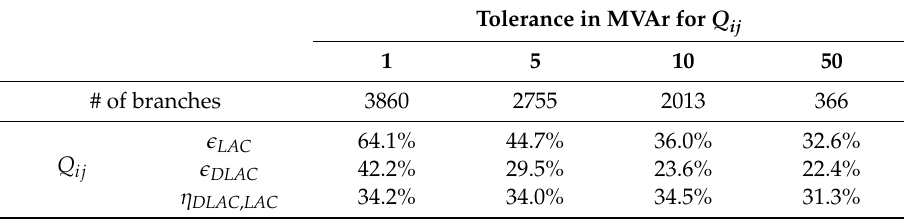
Table 8. Results of Reactive Power with DLAC and LAC for Hour 1